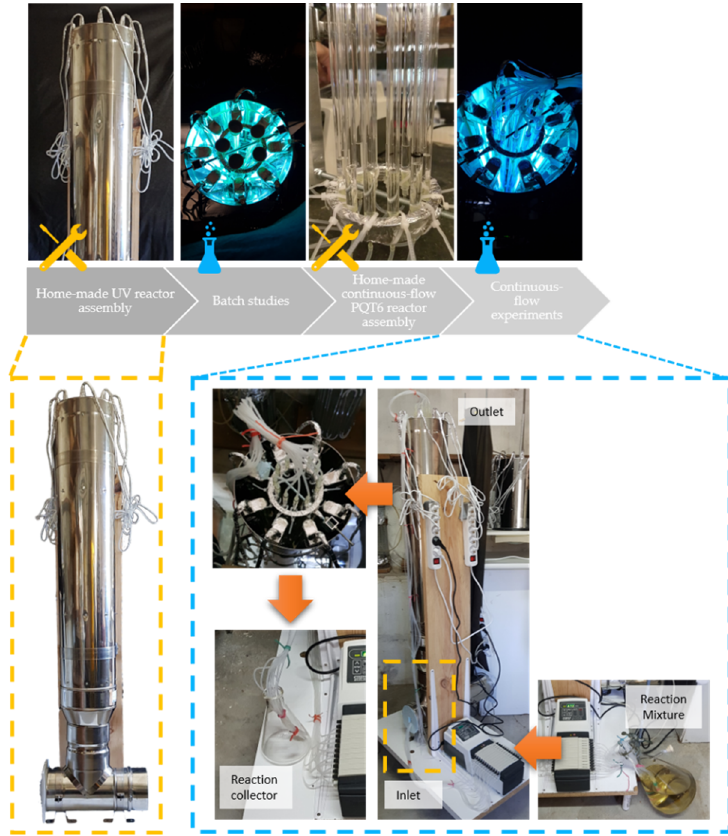
Figure 3. Workflow overview.